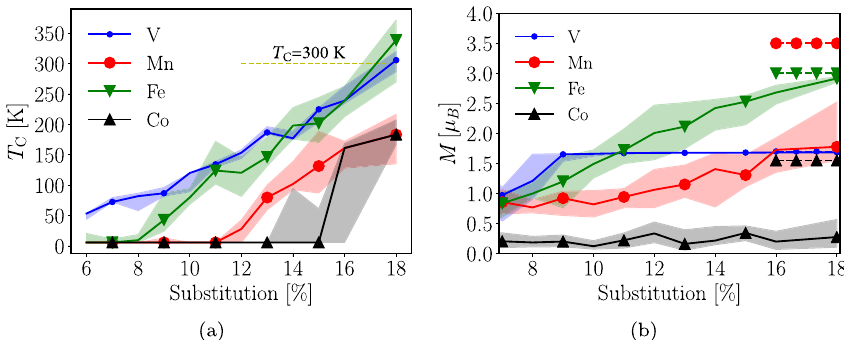
Fig. 2 Critical temperature and magnetization of doped MoSe 2 . a Critical temperature (Curie temperature for V and Co and K-T transition temperature for Fe and Mn) of V, Mn, Fe, and Co-doped MoSe 2 as a function of atomic substitution. The solid lines show the median critical temperature obtained from the MC simulations, and the shading shows the variance between the 25th and the 75th percentile. b The average magnetization of V, Mn, Fe, and Co-doped MoSe 2 as a function of atomic substitution. The solid lines show the median magnetization obtained from the MC simulations, and the shading shows the variance between the 25th and the 75th percentile. The dotted lines show the starting saturation magnetization for each dopant, obtained from Table 1. Starting magnetic moments.